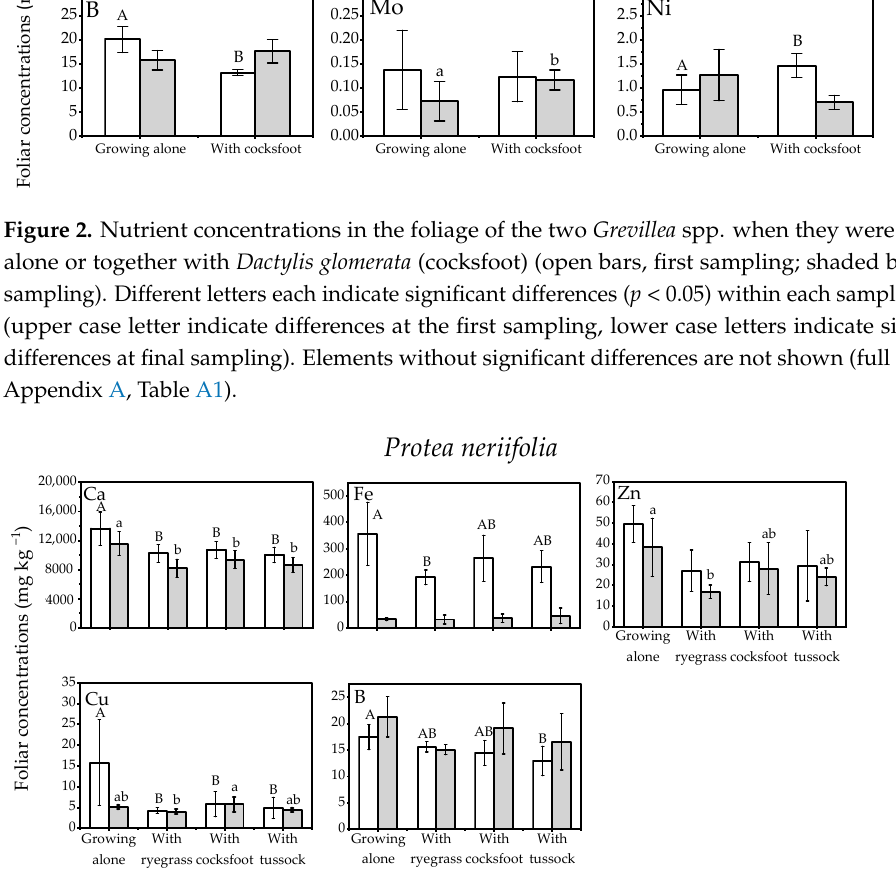
Figure 3. Nutrient concentrations in the foliage of the Protea neriifolia when grown alone or together with the three species of grass: Lolium perenne (ryegrass), Dactylis glomerata (cocksfoot), or Poa cita (tussock grass) (Open bars, first sampling; Shaded bars, final sampling). Different letters each indicate significant differences ( p < 0.05) within each sampling event (upper case letters indicate differences at the first sampling, lower case letters indicate significant differences at final sampling). Elements without significant differences are not shown (full results in Appendix A, Table